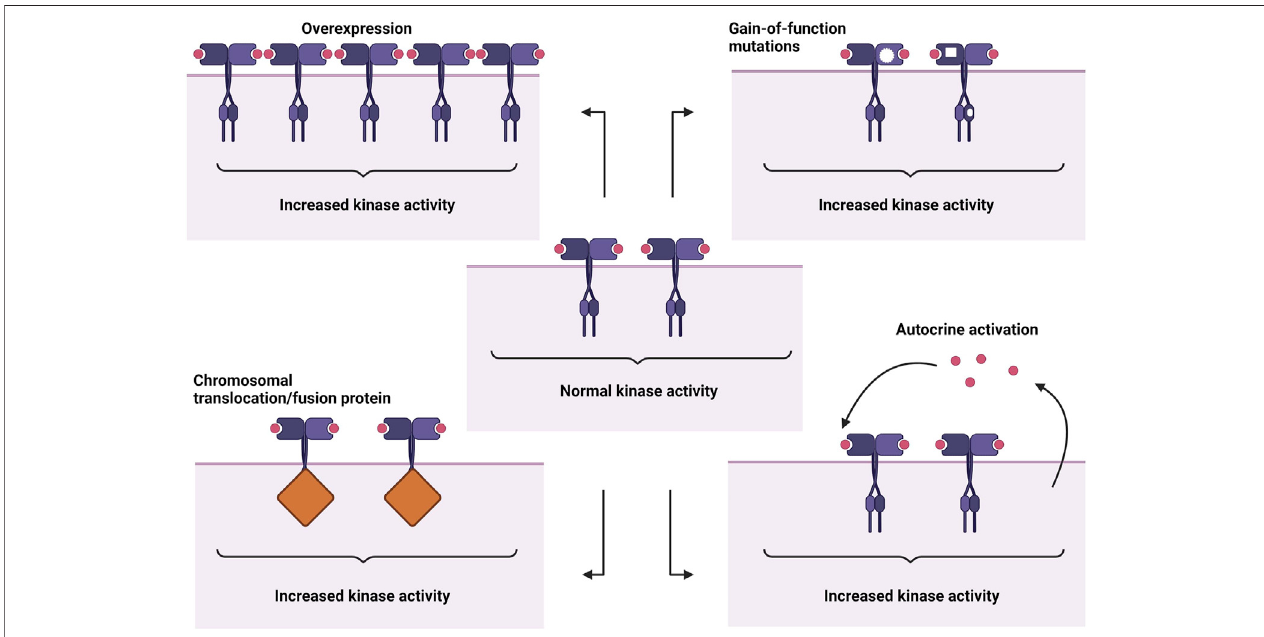
FIGURE 1 | Abnormal RTK activation mechanisms. From top left: overexpression, gain-of-function mutations, autocrine activation, chromosomal translocation/ fusion protein. Created with BioRender.com.